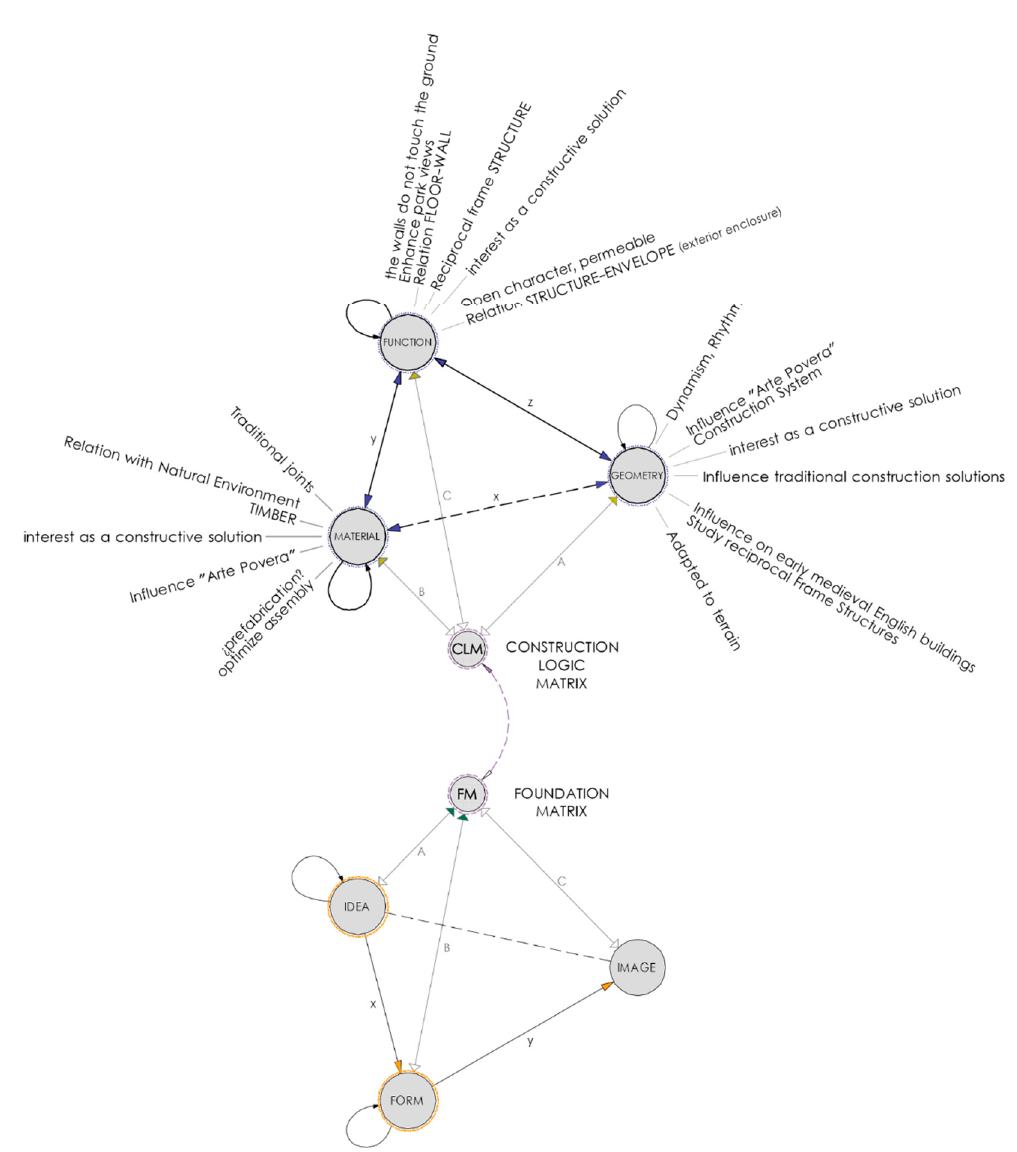
Figure 11. Matrices 3D model workflow and inputs from FM to CLM. Orange (x, y) for interaction between Idea, Form, and Image. Dark green for connections (A, B, C) from Idea, Form, and Image to FM global approach. Purple for relationships within matrix global approach. Light green for relationships (A, B, C) from CLM to its components. Blue for interactions (x, y, z) between Geometry, Material, and Function.